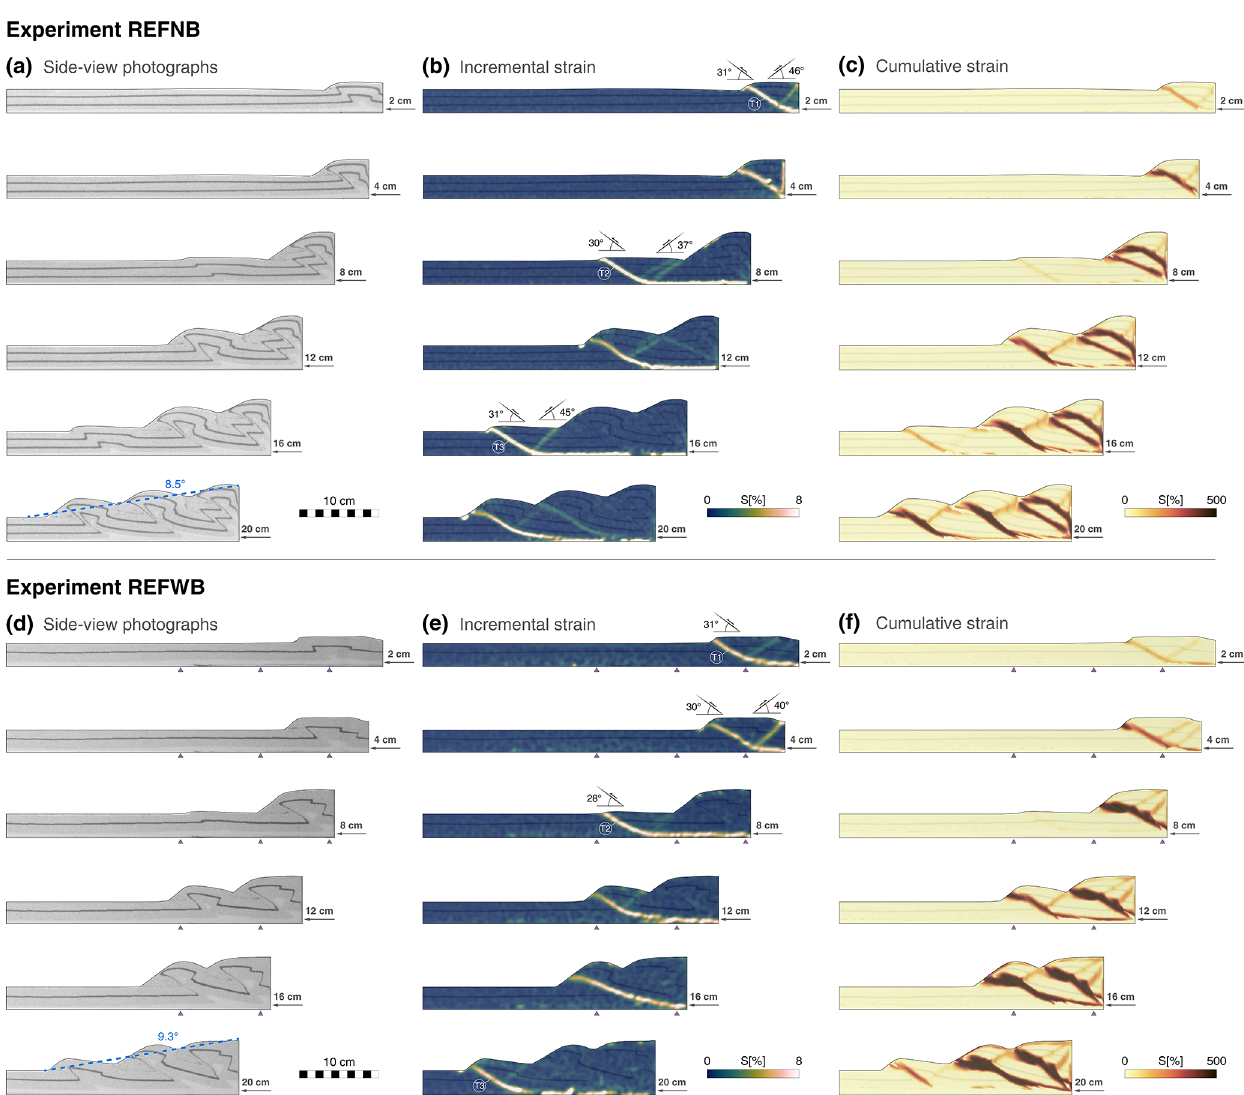
Figure 4. Deformation evolution, comparison between reference experiments. Experiment REFNB, no basal sheet: (a) side-view pho- tographs, (b) incremental strain, and (c) cumulative strain. Experiment REFWB, with basal sheet: (d) side-view photographs, (e) incremental strain, and (f) cumulative